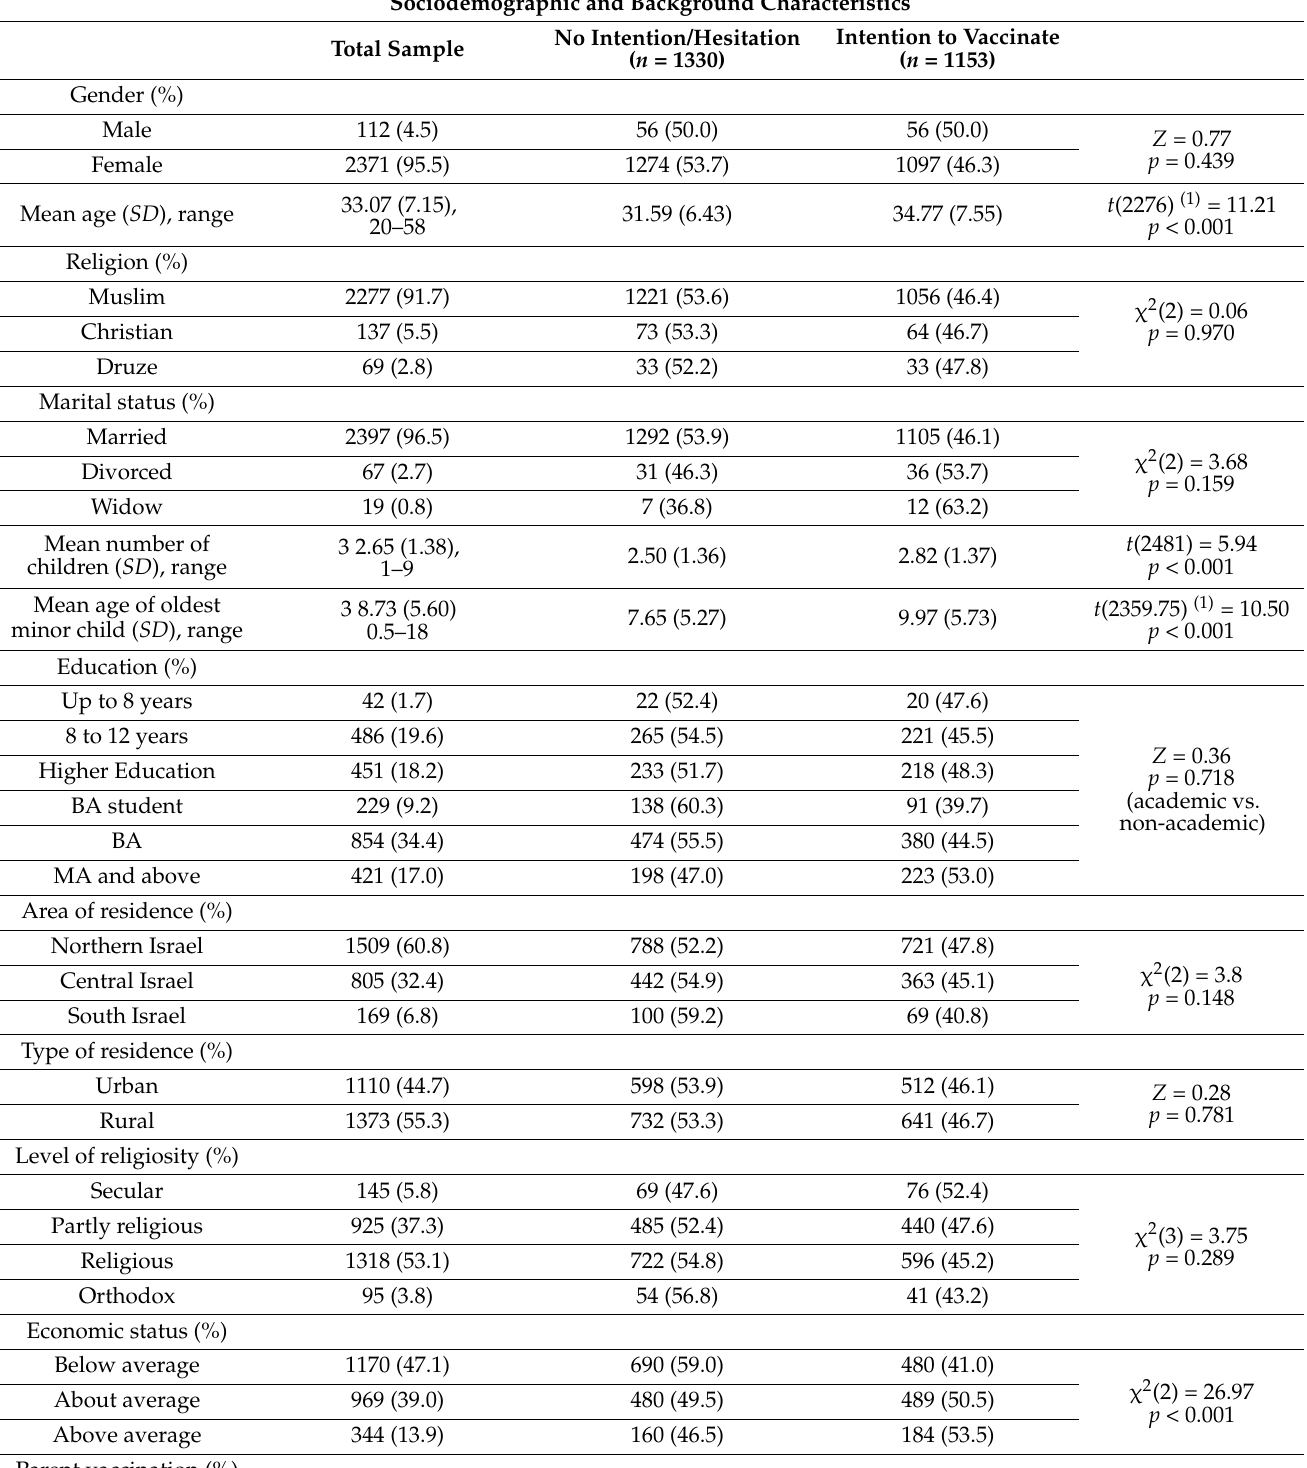
Table 1. Background characteristics by the intention to vaccinate ( N =